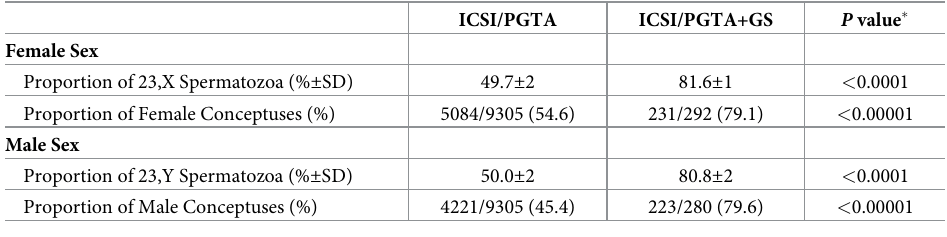
Table 2. Proportion of sperm cells enrichment and resulting embryos for female and male sex.